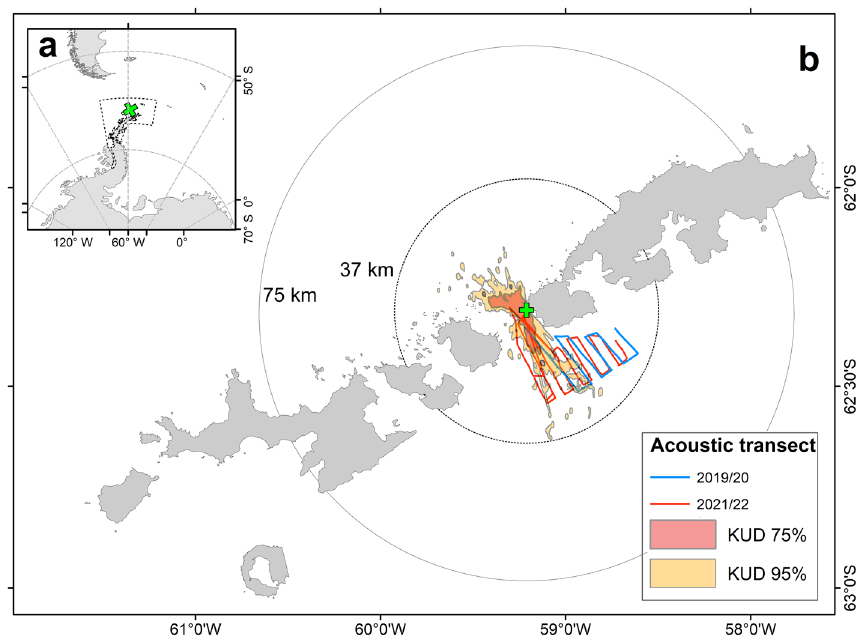
Figure 1. Location of the study area over a wide ( a subarea 48.1, dashed line) and over a local geographical context ( b ). The green cross shows the position of Harmony Point, Nelson Island, where the foraging range (Kernel Usage Densities KUD) and foraging behaviour of breeding chinstrap penguins were studied in 2019/20 and 2021/22 breeding seasons. A 37 km radius around the penguin breeding colony indicates the farthest distance from the colony on a straight line; environmental variables compared between seasons were extracted within a 75 km radius around the breeding colony. Solid lines depicted the acoustic transects carried out on board the RS Karpuj in both seasons. Map created using ArcMap 10.8.2 (https:// www. esri. com/). Land contours from Esri Global Mapping International (https:// www. arcgis. com/; item